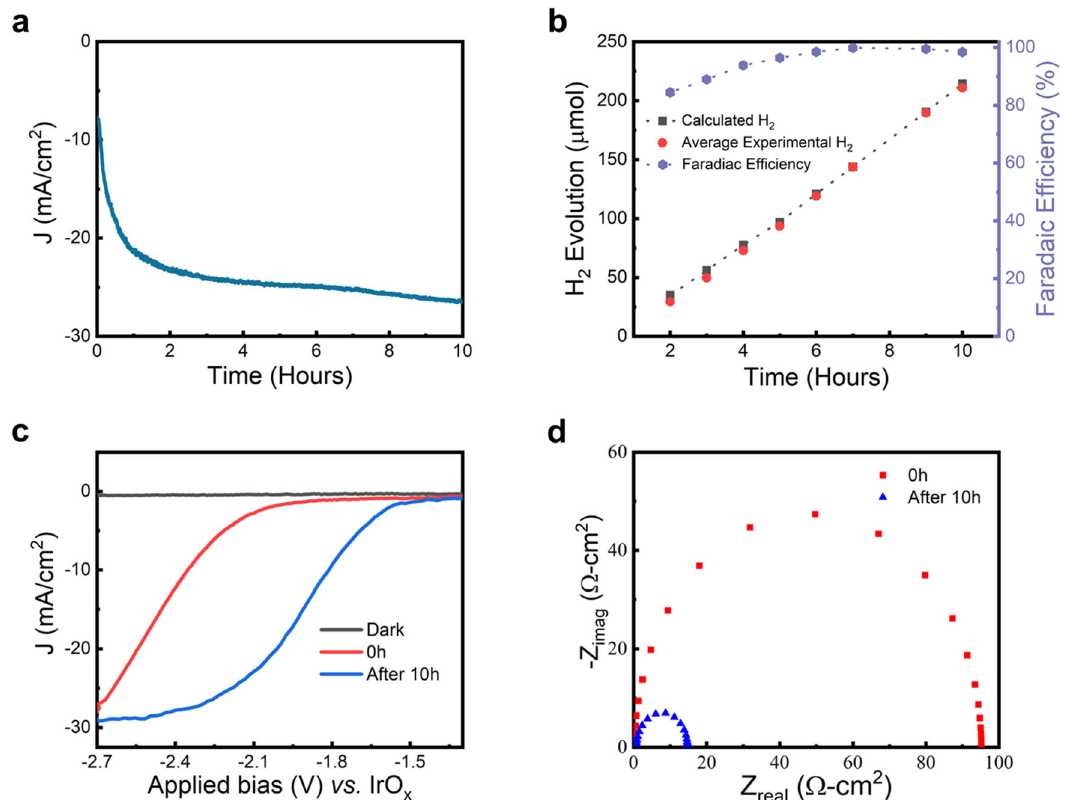
Fig. 2 | Photocathodes evaluated in a two-electrode con fi guration. a The initial 10hofthechronoamperometry(CA)stabilitytestofthephotocathodeat − 2.3V vs . IrO x underAM1.5Gone-sunilluminationin0.5MH 2 SO 4 with0.2mMTritonX-100. b Faradaic ef fi ciency measurements of the fi rst 10h of the CA. The red dots represent the average amount of H 2 measured at different times via gas